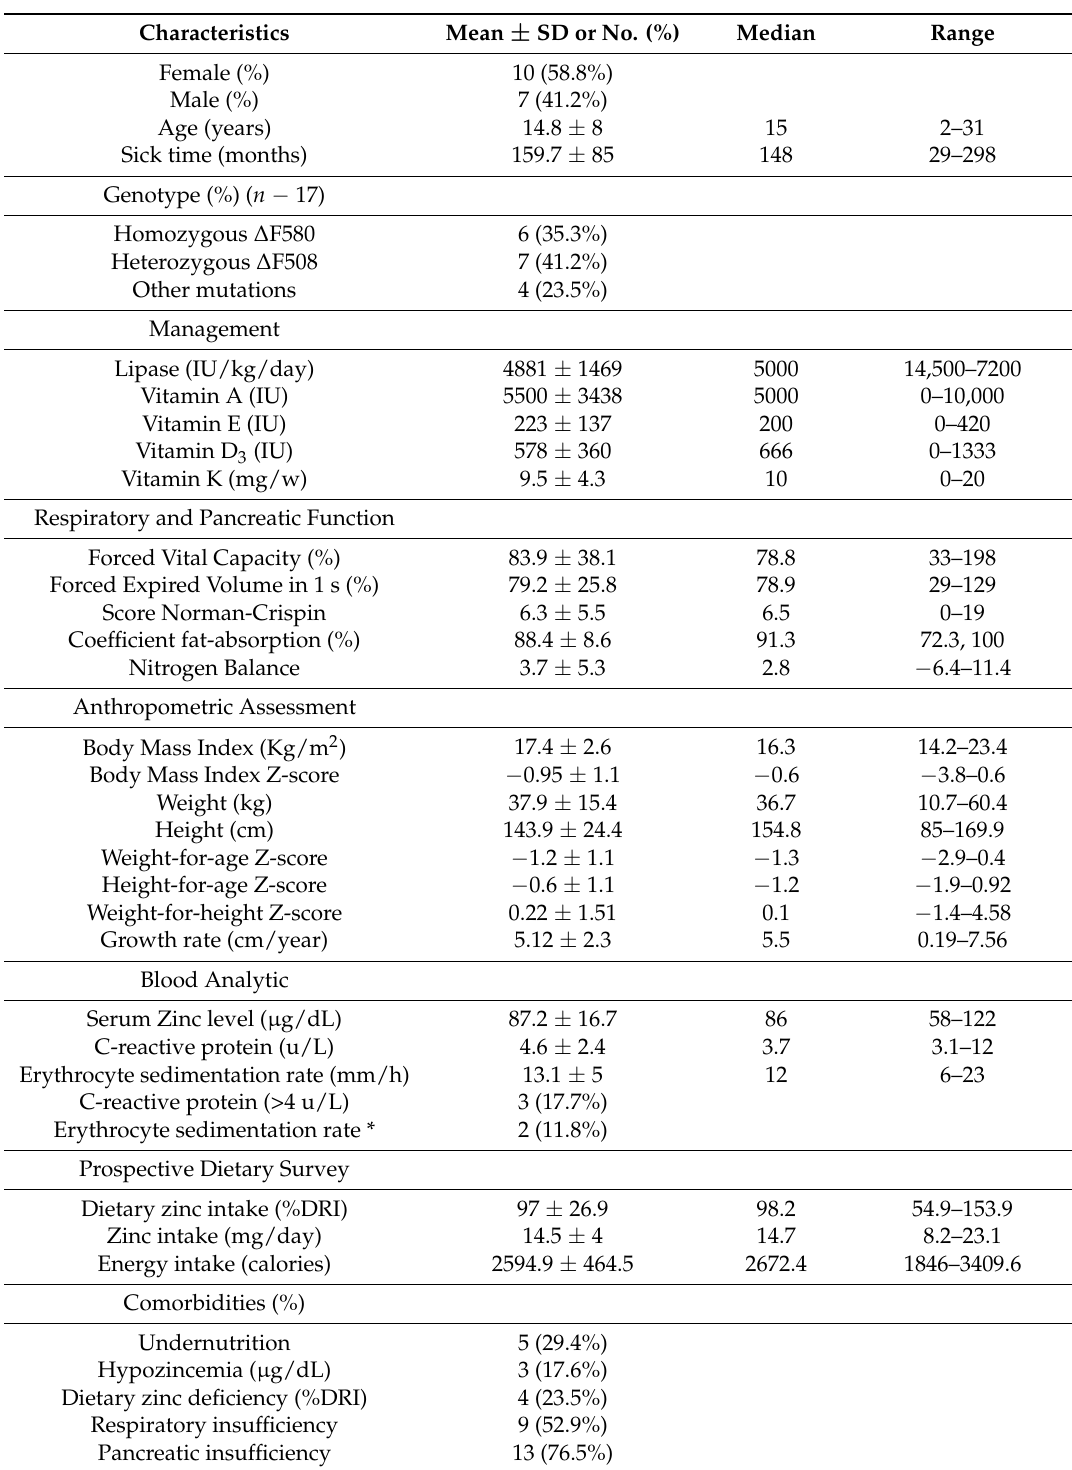
Table 1. Baseline Characteristics of the Subjects (N = 17